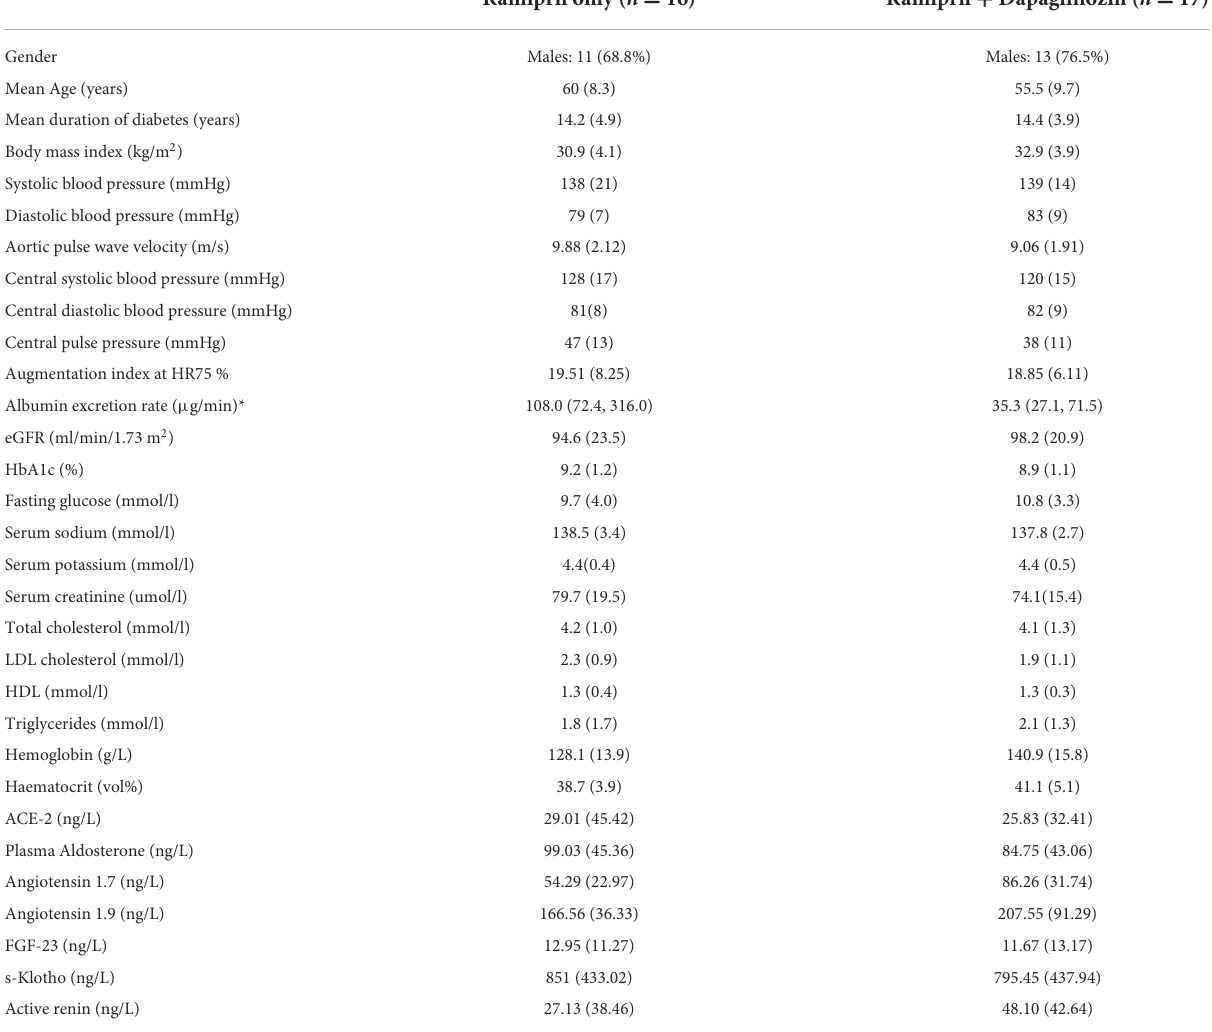
TABLE 1 Baseline data of 33 patients who were eligible for analyses of primary and secondary endpoints randomized to Ramipril or Ramipril + Dapagliflozin treatment arms. Ramipril only ( n =